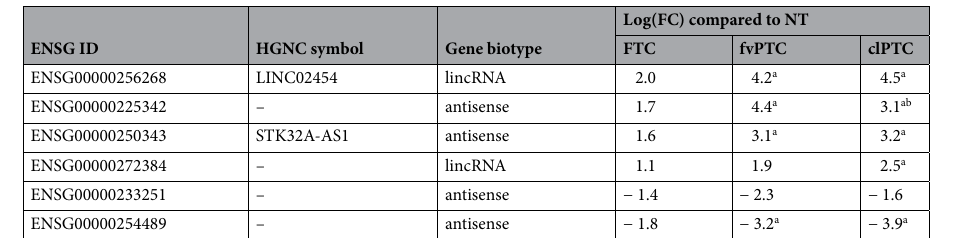
Table 3. LncRNAs common for WDTC. Differential expression of all genes is validated in clPTC and fvPTC. Expression in fvPTC and clPTC differs significantly compared to FA. a significantly differentially expressed compared to FTC; b significantly differentially expressed compared to